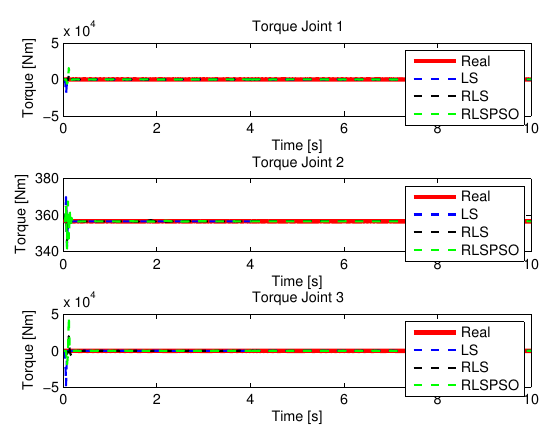
Figure 40. Acceleration identifications.